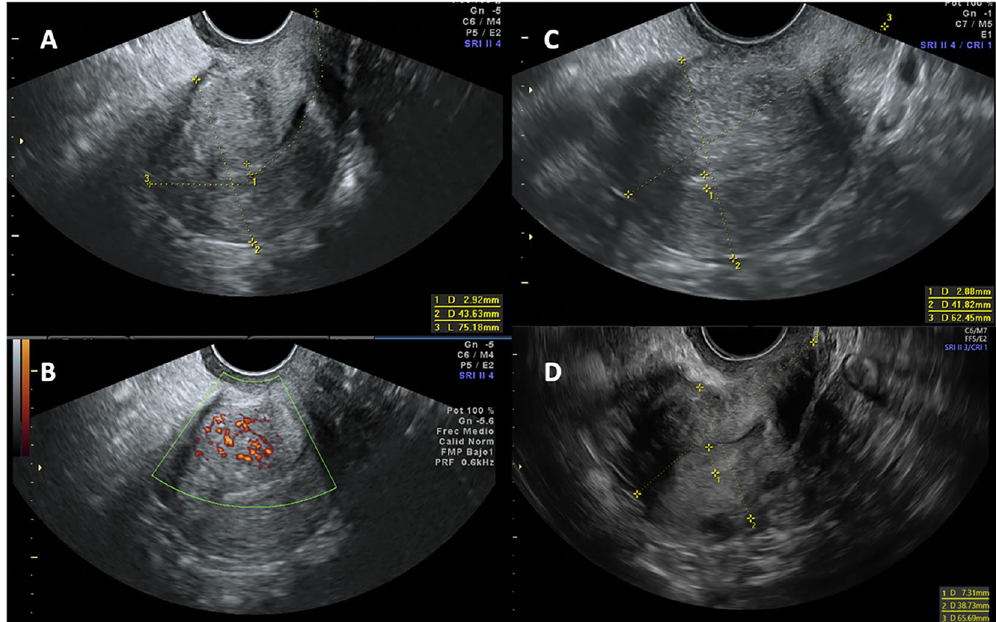
Figure 2. Adenomyosis sonographic evolution at baseline and at 12 and 24 months of follow-up. ( A and B ) Baseline ultrasound with the presence of 5 adenomyosis criteria; ( A ) Hyperechoic islands, fan-shaped shadowing, uterine wall asymmetrical thickening, interrupted junctional zone and ( B ) Translesional vascularity; ( C ) 12-month follow-up with hyperechoic islands and uterine wall asymmetrical thickening as mild signs of adenomyosis. ( D ) 24-month follow-up with no signs of